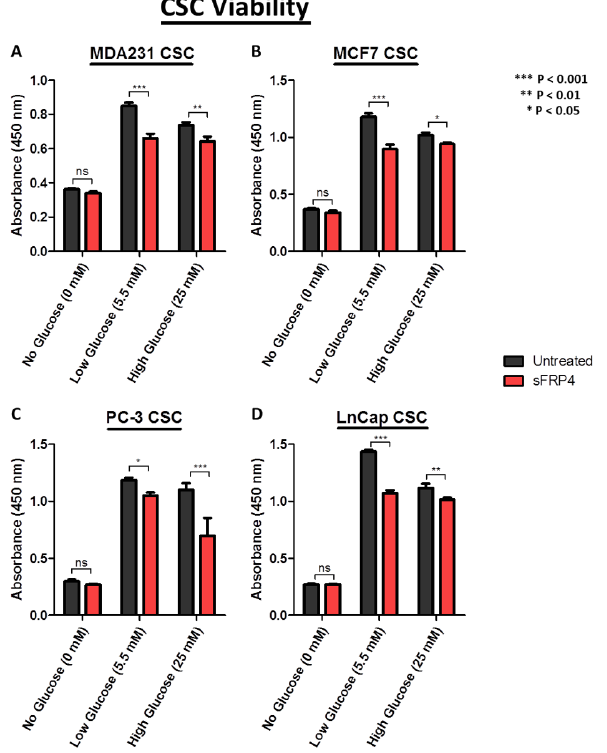
Figure 2. Effect of sFRP4 on CSC viability: Viability assay was performed using Cell Counting Kit-8 after treatment of CSCs derived from ( A ) MDA231; ( B ) MCF7; ( C ) PC-3; and ( D ) LnCap cell lines treated with sFRP4 for 24 h. Statistical analysis was performed using ANOVA for analysis variance with Bonferroni test for comparison showing significance as *** p < 0.001; ** p < 0.01; * p < 0.05. Data are mean ± standard error of mean from three independent experiments.